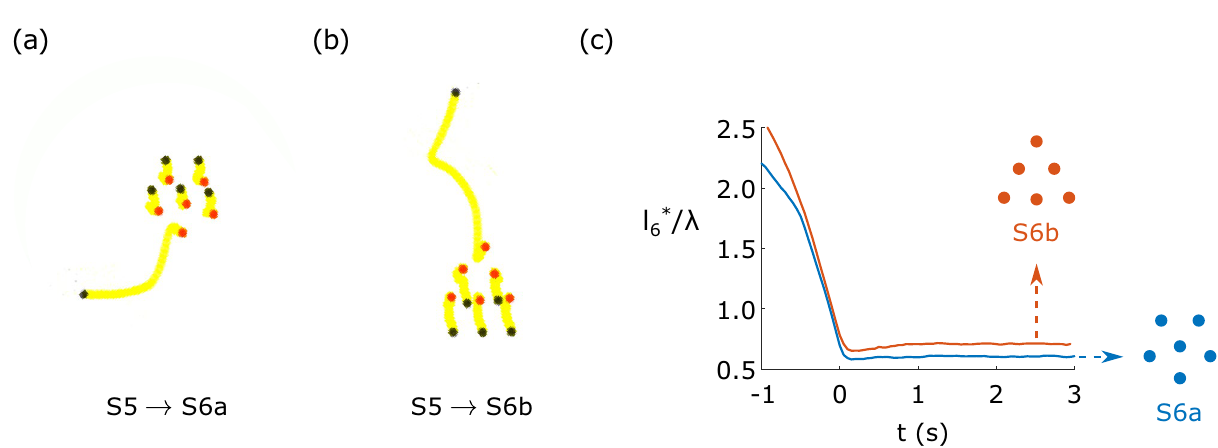
Figure 7. Experimental results showing the transitions from S5 to S6a and S6b for B z initial particles positions, in yellow the particles trajectories and in red the final state. In both cases, the sixth particle was approached to the existing S5 crystal in the desired direction using the thermocapillary actuation system. ( a ) Transition from a S5 to S6a. ( b ) Transition from S5 to S6b. ( c ) Normalized distance l ∗ 6 / (cid:31) between the new particle and the center of mass of the other five particles, in function of